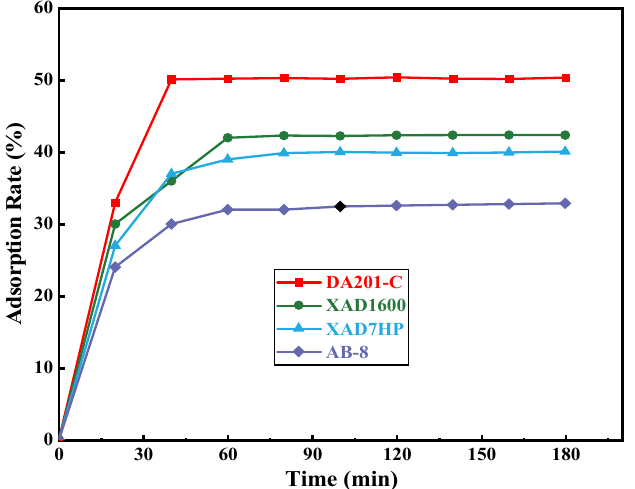
Figure 8. Comparison for purification effects of different macroporous resins. DA201-C, XAD1600, XAD7HP, and AB-8 are different types of macroporous resins, respectively.